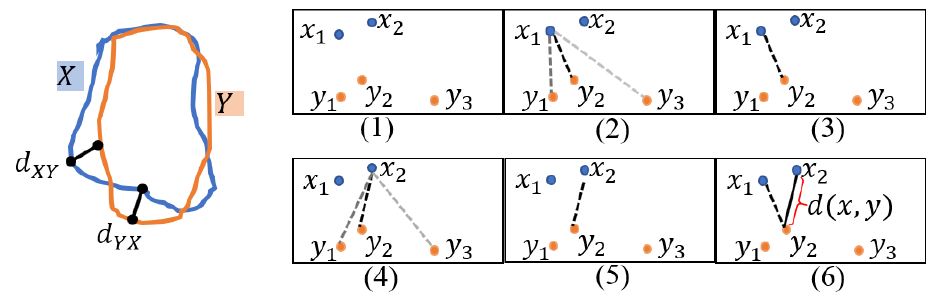
Figure 5. An example of an HD calculation.